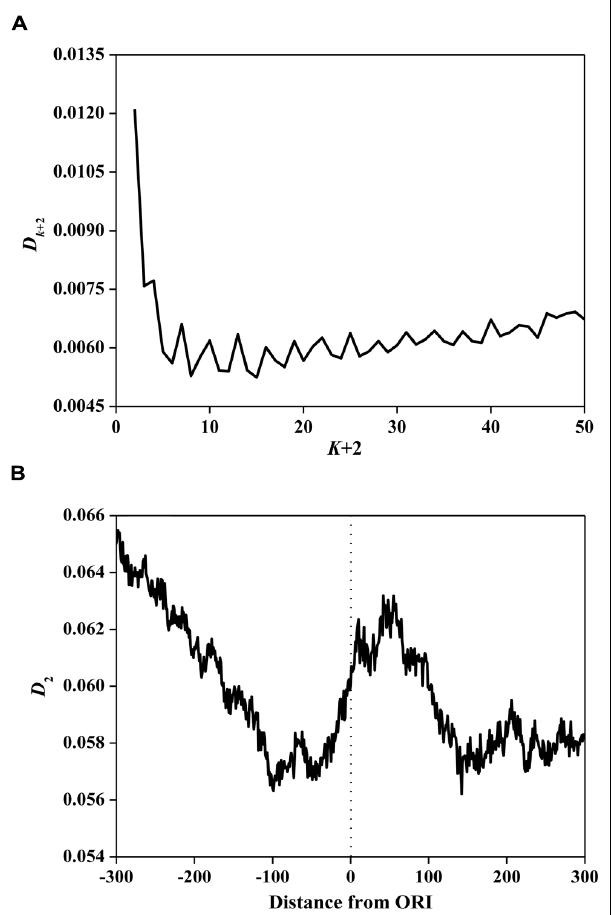
FIGURE 2 | (A) Average D k + 2 vs. k + 2 for the ORI sequences.The horizontal axis represents the gap of k + 2.The vertical axis represents the value of D k + 2 . (B) The distribution of D 2 surrounding ORIs.The horizontal axis represents the nucleotide position, which ranges from − 300 bp to + 300 bp relative to ORIs (denoted as 0).The vertical axis represents the value of D 2